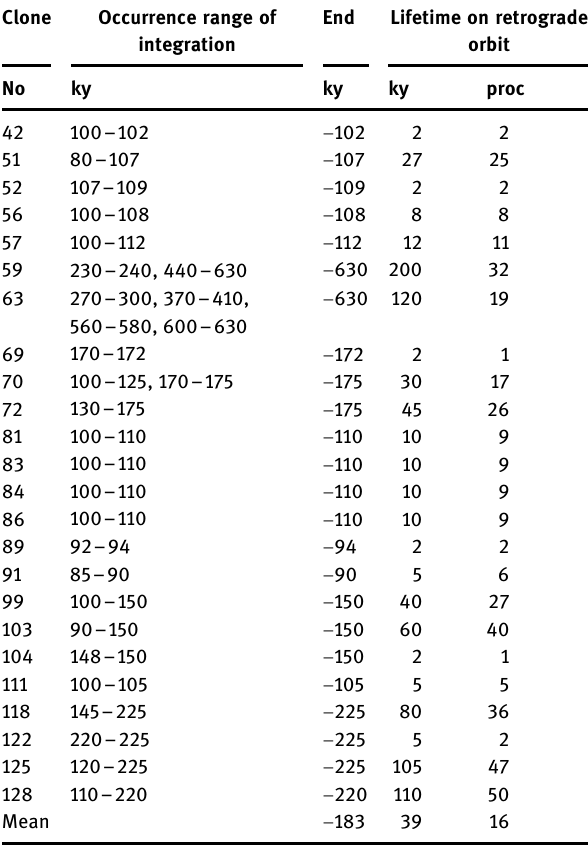
Table 6: Backward integration without NG e ff ects, the lifetime of clones in a retrograde orbit Clone Occurrence range of